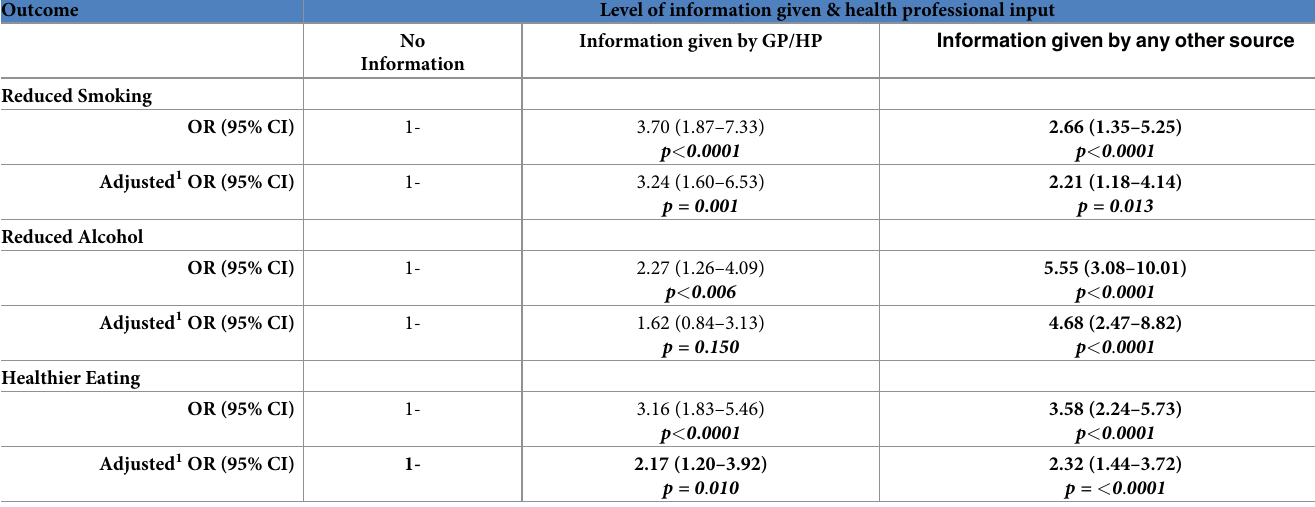
Table 4. Behaviour change for smoking, alcohol and dietary behaviour and information given by a health professional or any other source versus no information